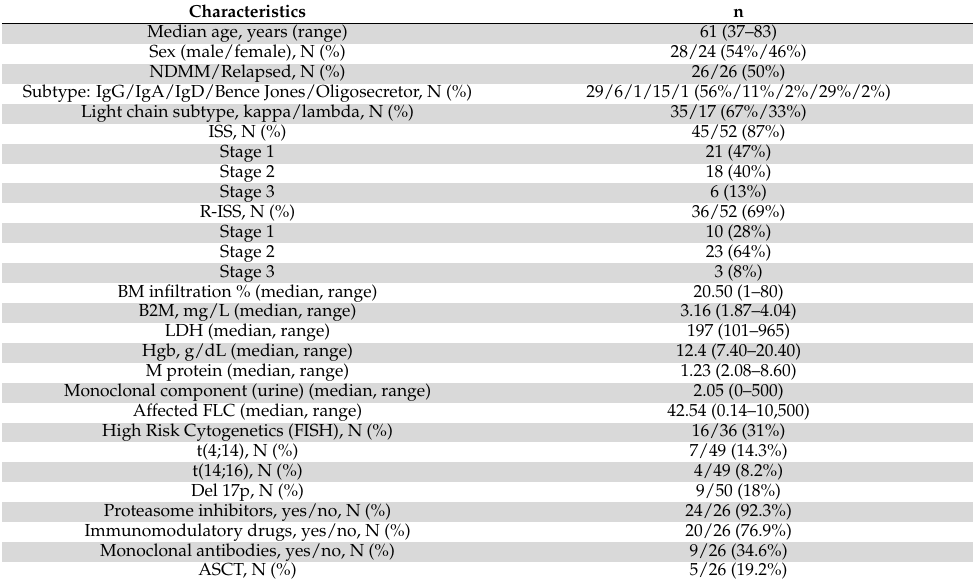
Figure 2. Flow chart of the study population.